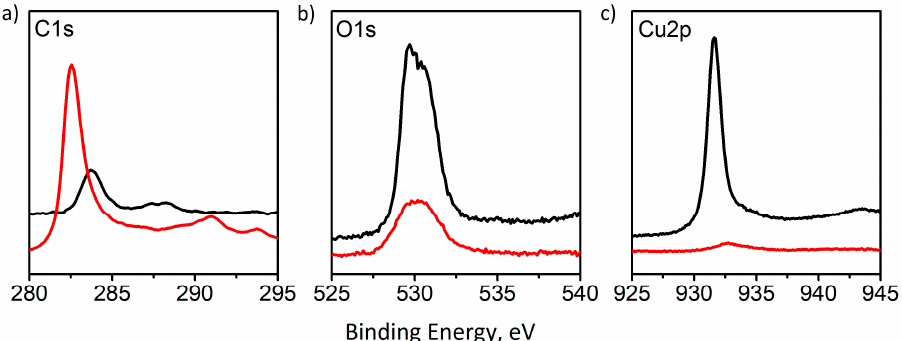
Figure 3. XPS spectra recorded for the GDE surface before (black curve) and after (red curve) 80 min of electrolysis at the current density of 200 mA·cm − 2 . ( a ):C1s; ( b ):O1s; ( c ):Cu2p.